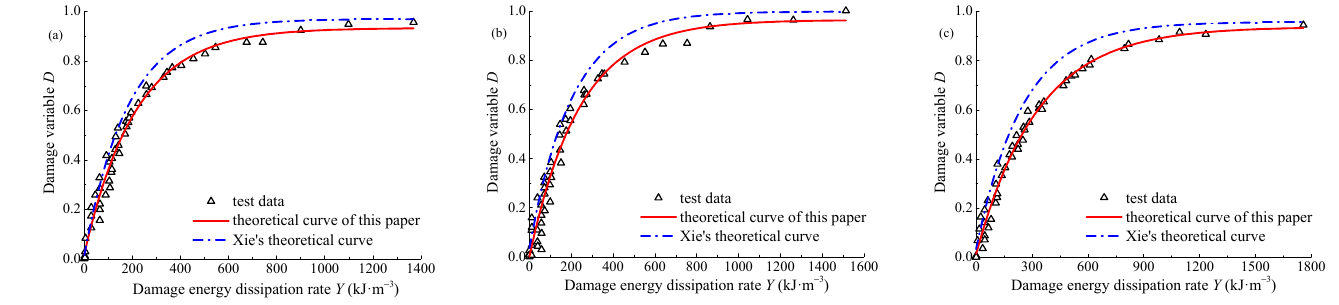
Figure 14. Model validation: ( a ) α = 0.02 mol·L − 1 ; ( b ) α = 0.06 mol·L − 1 ; ( c ) α = 0.10 mol·L − 1 .